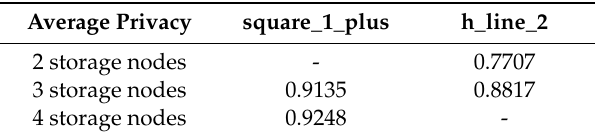
Table 4. Average privacy achieved by the DCA for the topology of 100 nodes.